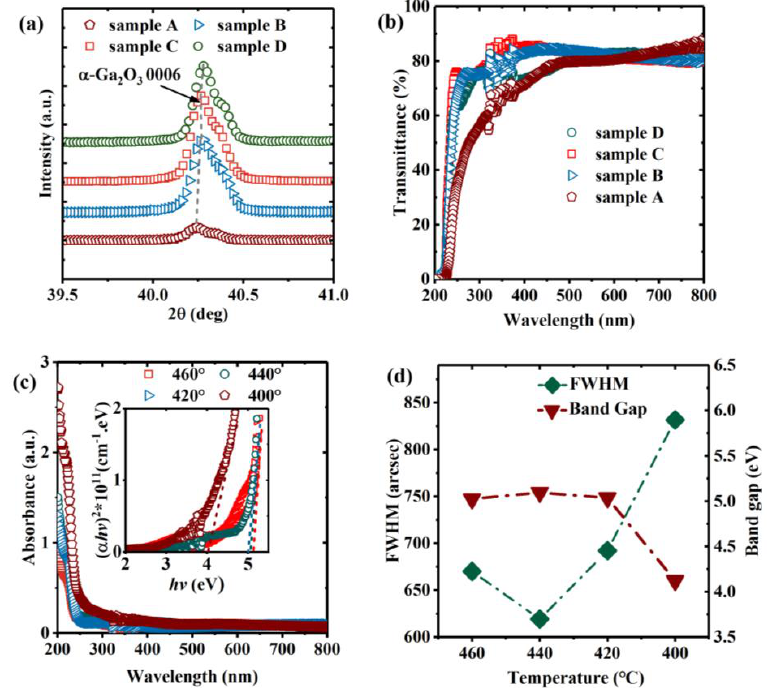
Figure 2. ( a ) XRD θ -2 θ diffraction profiles of α -Ga 2 O 3 films; ( b ) optical transmittance, ( c ) optical absorption spectra, ( d ) bandgaps, bandgap errors, and FWHMs of α -Ga 2 O 3 films.